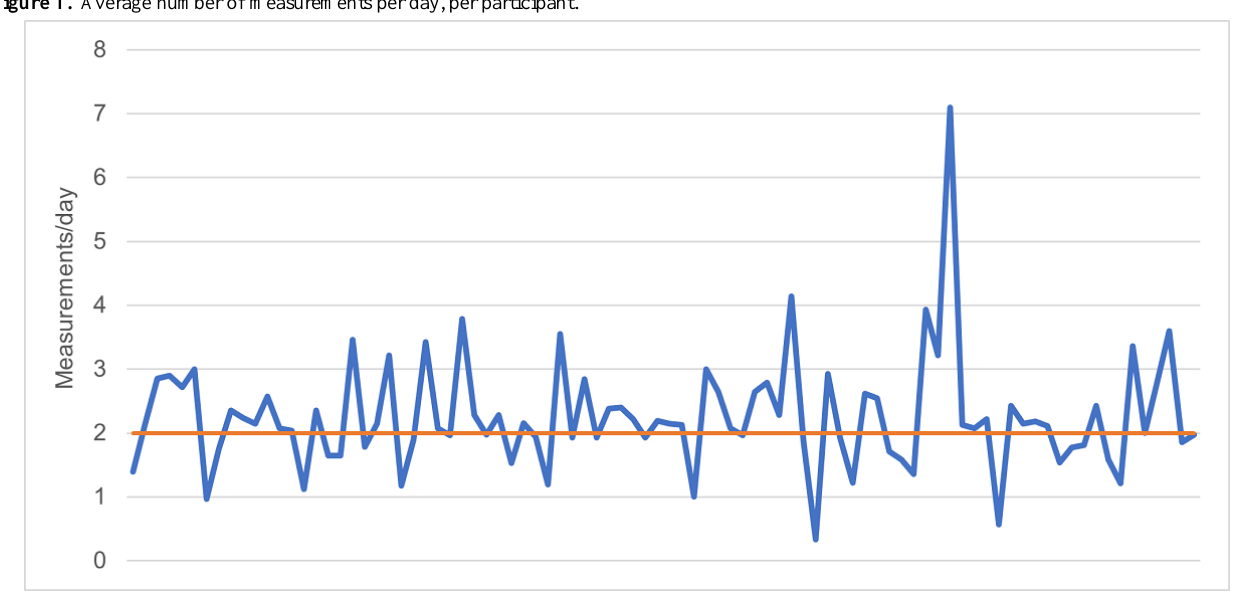
Figure 1. Average number of measurements per day, per